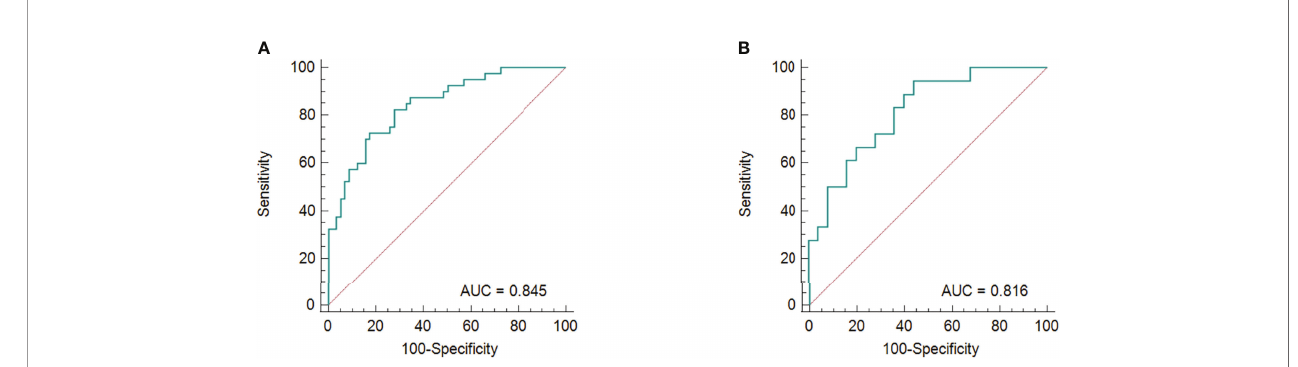
FIGURE 6 | The ROC curves for the radiomics nomogram in the training group (A) and validation cohort (B)